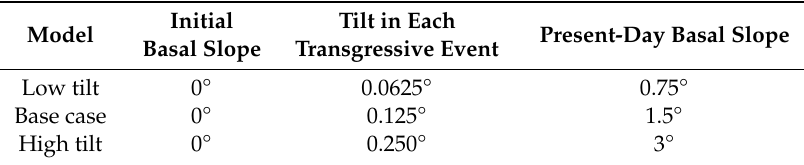
Table 2. Values of subsidence tilt angle in the models set.